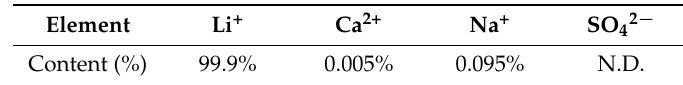
Table 4. The element content of the lithium carbonate after the hydrogenation–decomposition and the ion-exchange.